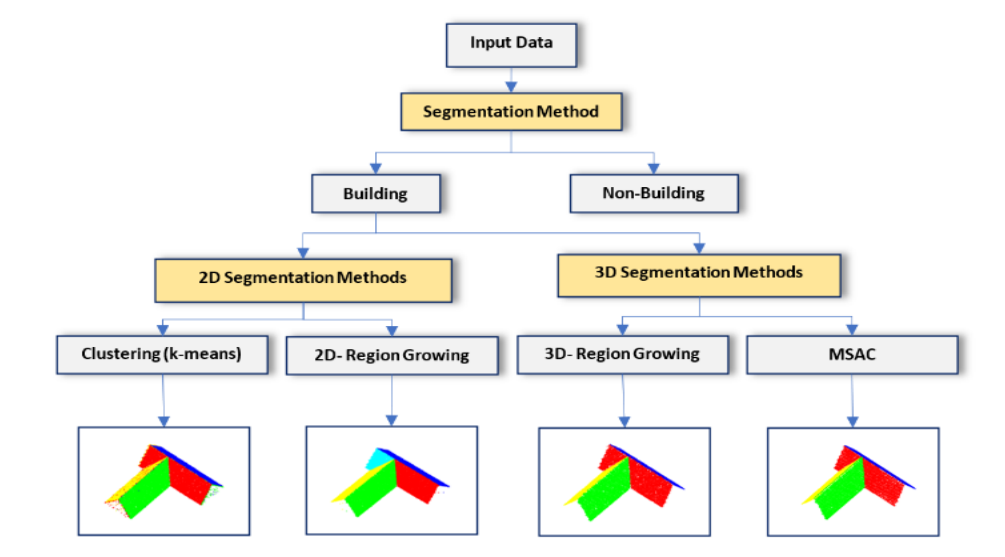
Figure 2 . The flowchart of this